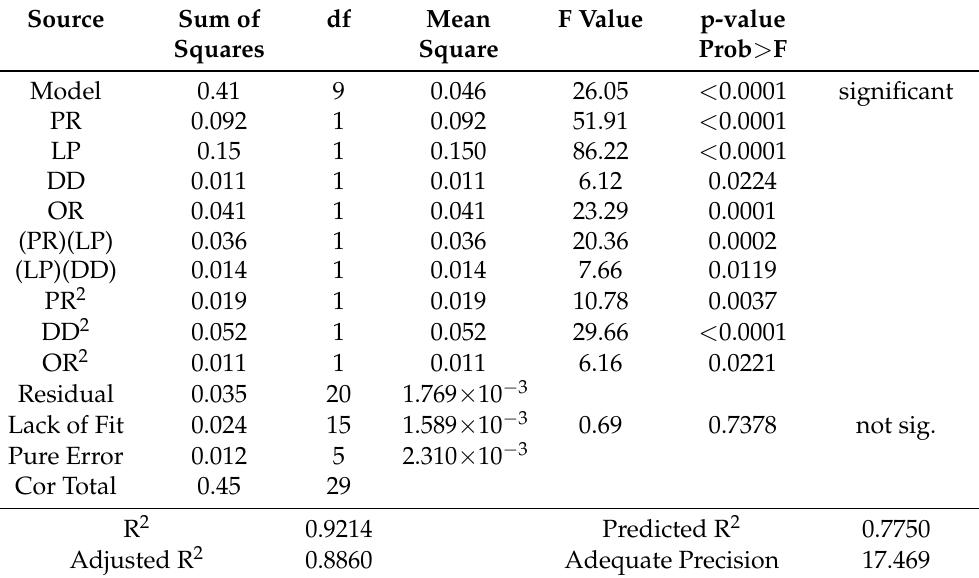
Table 13. ANOVA for